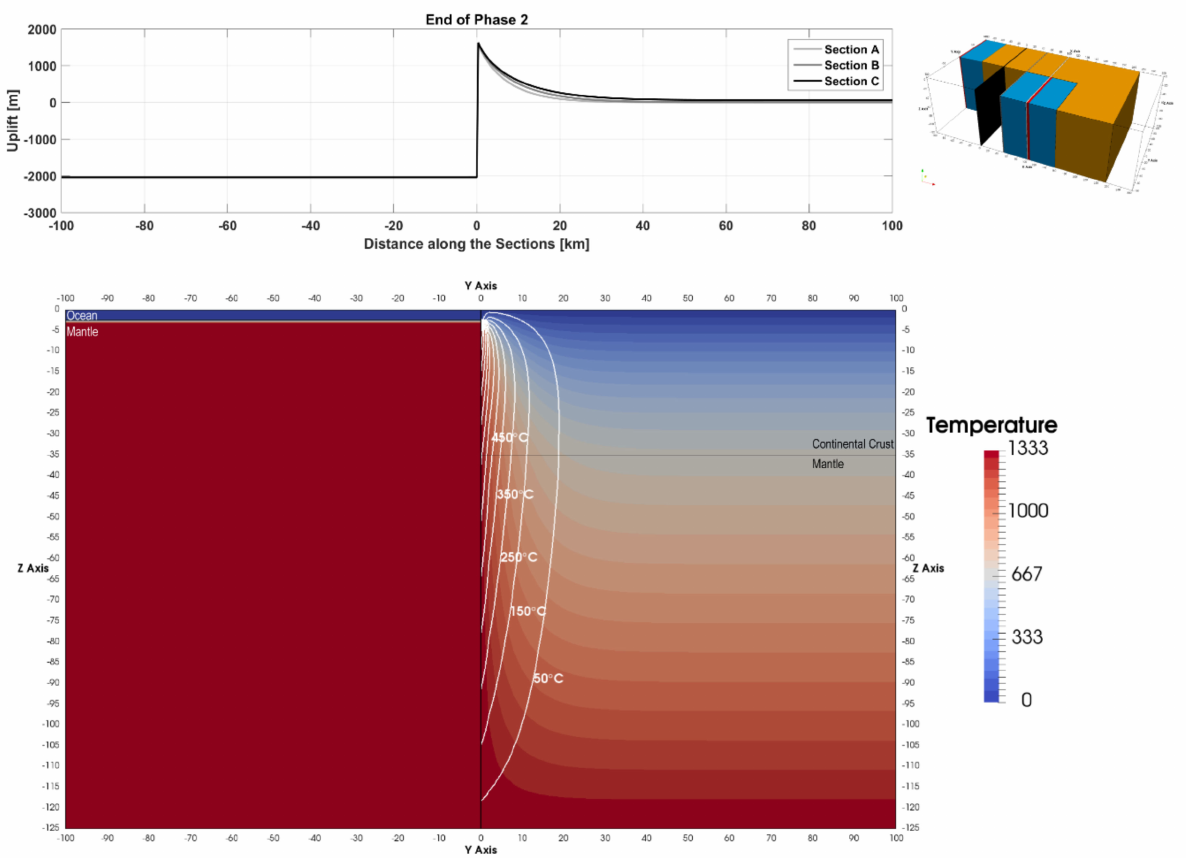
Figure 3. Thermal structure of the continental lithosphere along section A at the end of Phase 2 (5 Myr). The thermal anomaly (white contour) extends 19 km laterally into the continental lithosphere across the transform margin. The vertical central line denotes the transform margin. The lithosphere to the left of the margin is the leading edge of the 5 km wide ridge crest. The excess temperature contours are restricted to the northern side of the transform margin. The upper left panel shows the corresponding uplift calculated along all the sections at the end of Phase 2. Note that given their different initial positions, the time to reach the end of Phase 2 is different for the three sections. The upper right image shows the model configuration at the end of Phase 2 for Section